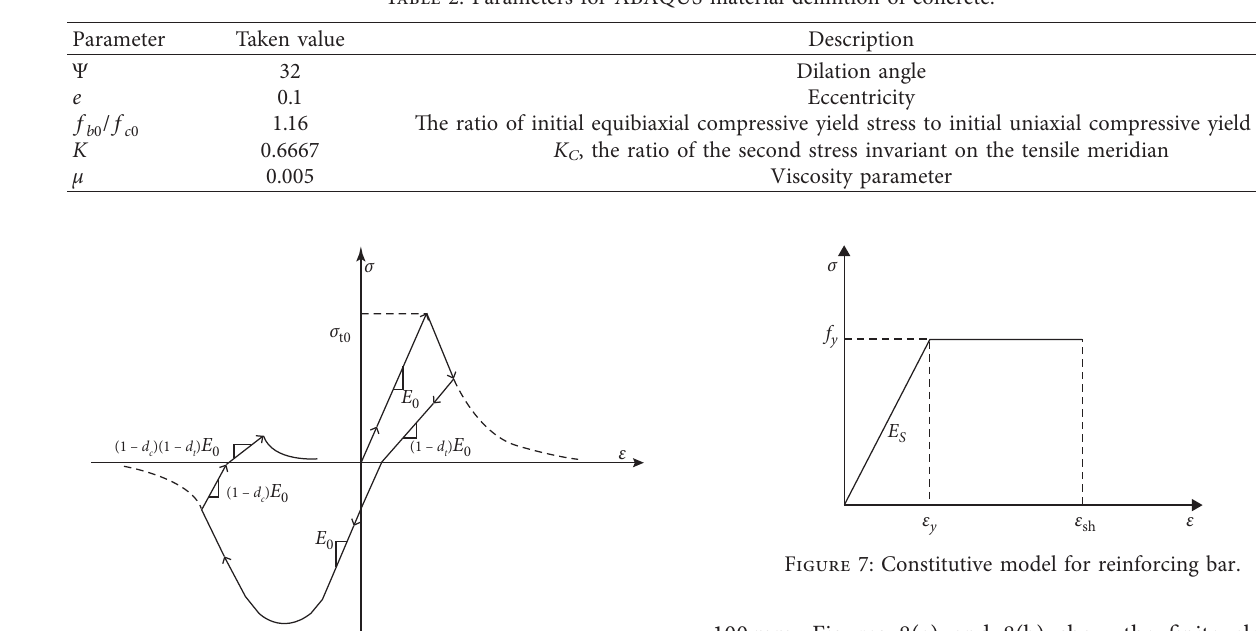
Table 2: Parameters for ABAQUS material definition of concrete.